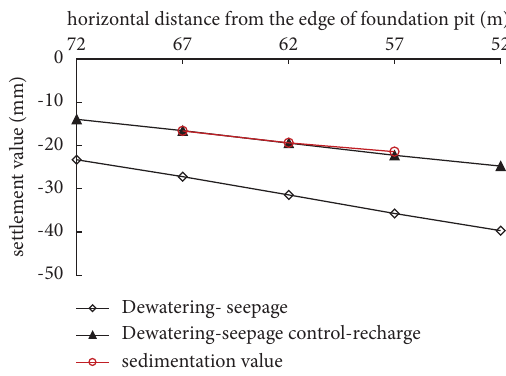
Figure 9: Settlement curves for the monitoring points under the two working conditions.